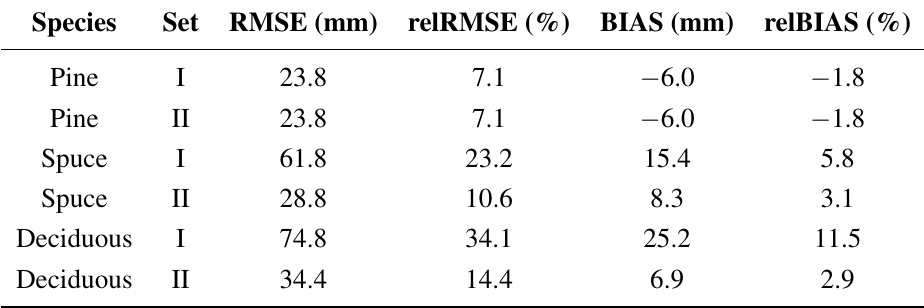
Table 4. Stem diameter estimates for different tree species, (I) complete dataset, and (II) dataset with the outliers removed.